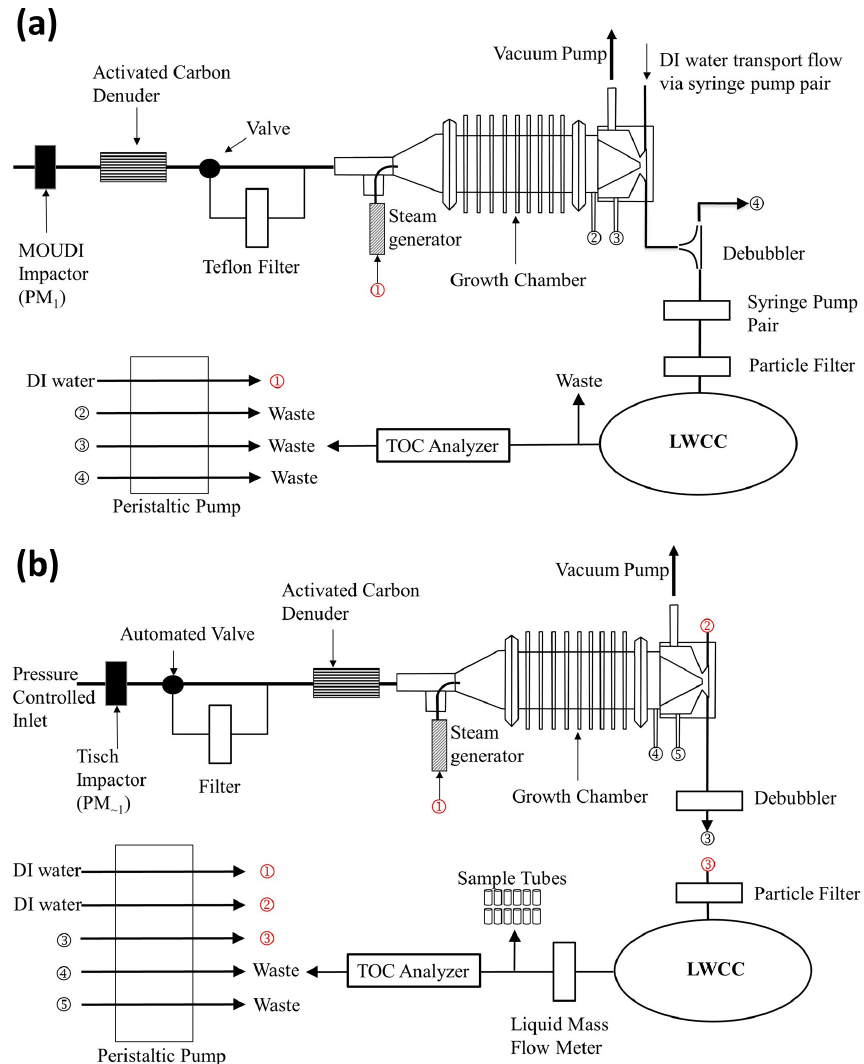
Figure 2. Flow diagrams of the (a) CSU PILS-LWCC and (b) NOAA PILS-LWCC instruments for WS BrC. For the CSU PILS-LWCC, a combination of syringe and peristaltic pumps was used for handling the liquid flows. For the NOAA PILS-LWCC, a peristaltic pump was used for all